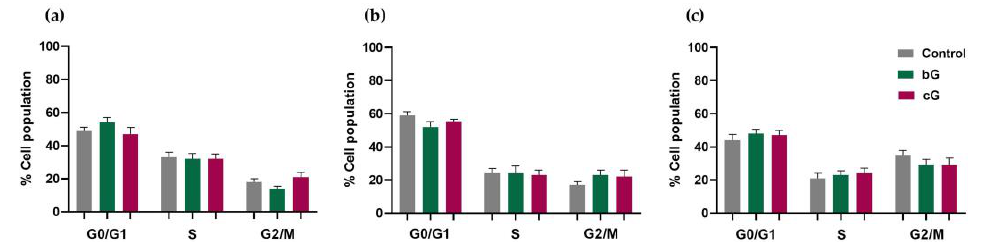
Figure 7. Cell cycle arrest after treatment for 24 h with bG or cG (20 μg/mL) in NIH/3T3 ( a ), HaCaT cells ( b ) and THP-1 derived macrophages ( c